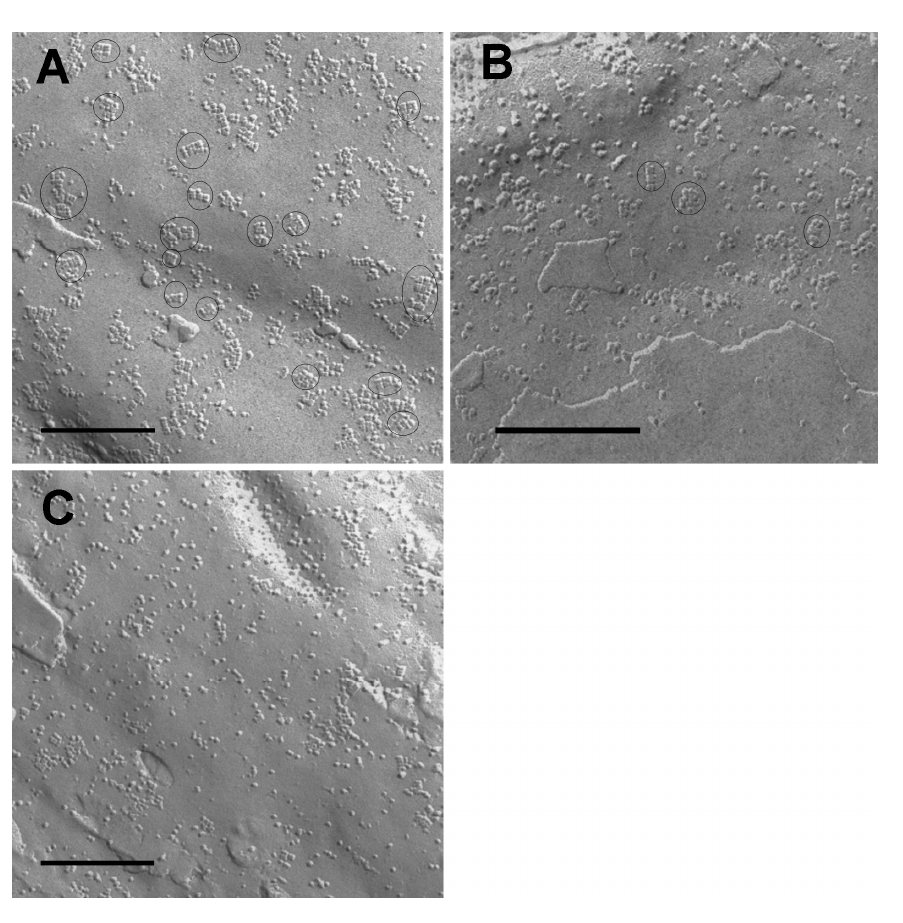
Figure 1. Freeze fracture replicas of low-grade to high-grade astrocytomas. ( A ) Astrocytoma World Health Organization (WHO) grade II showing orthogonal arrays of particles (OAPs) (encircled); ( B ) Astrocytoma WHO grade III showing less OAPs than in A (encircled); ( C ) IDH1 (isocitrate dehydrogenase 1 (NADP(+))-negative glioblastoma: No typical OAPs are found. Bar: 250 nm.